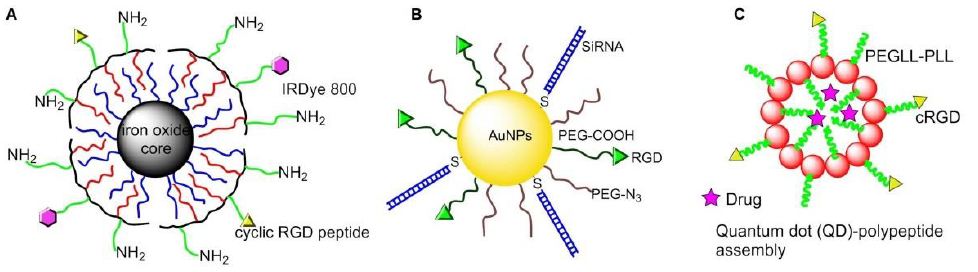
Figure 8. Integrin-targeted inorganic NPs and quantum dots (QDs): ( A ) magnetic NPs; ( B ) gold NPs; ( C ) QDs.